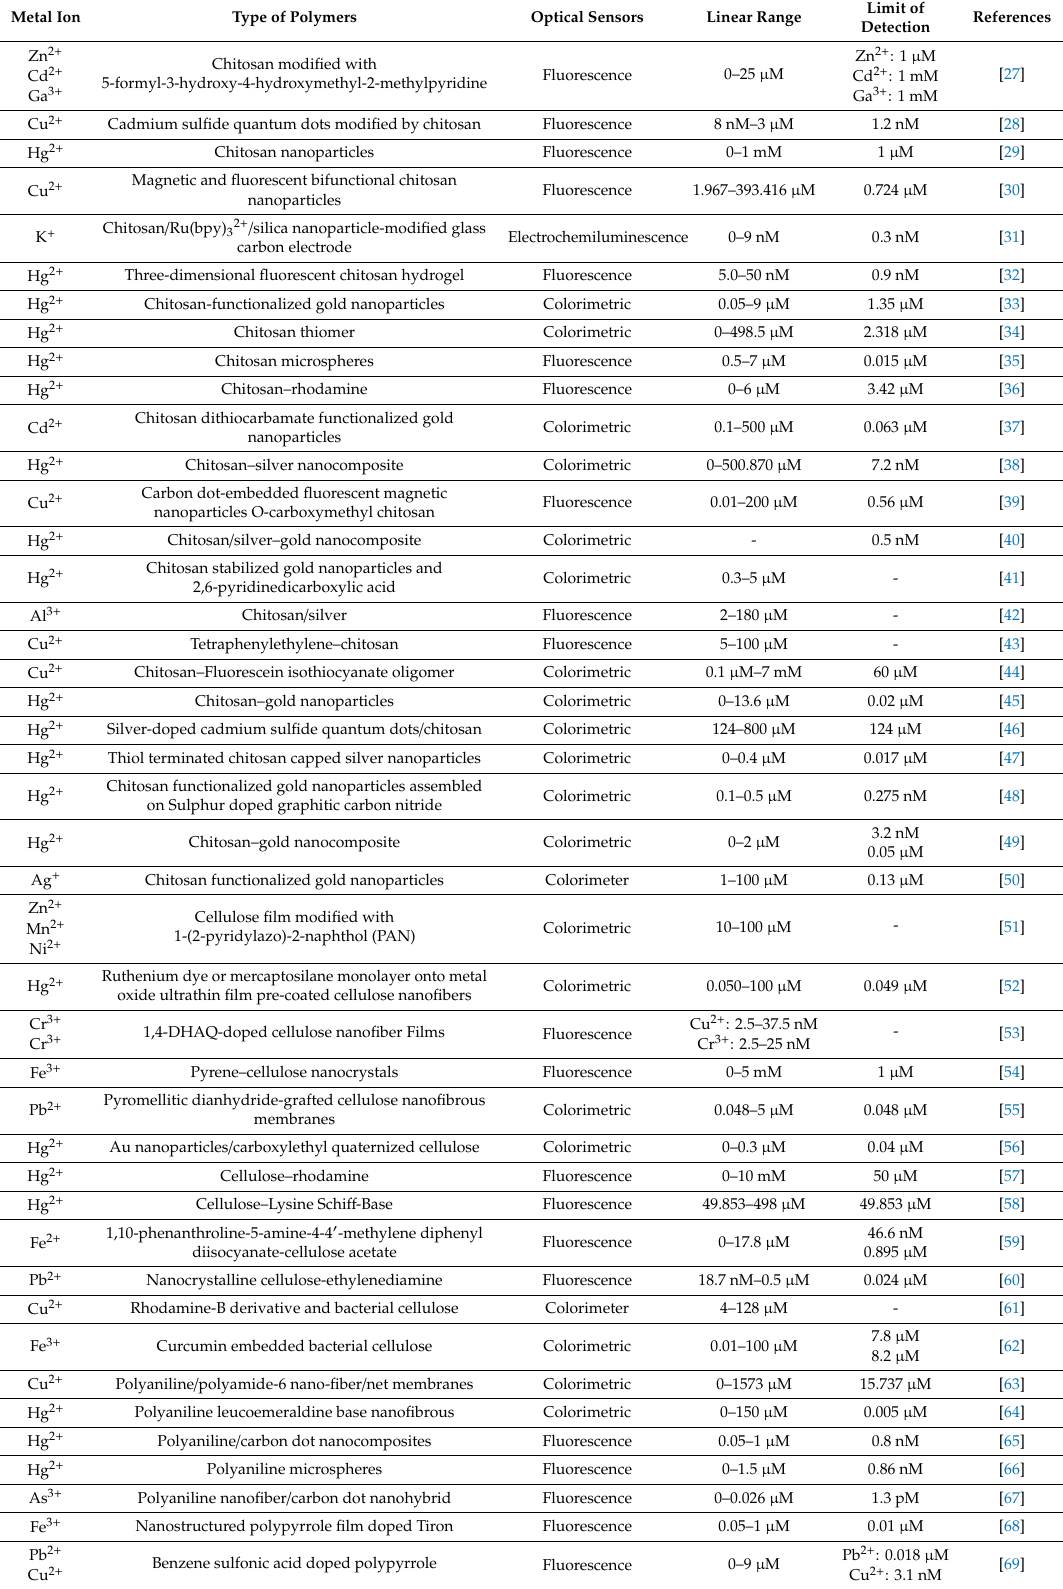
Table 1. The biopolymers and conducting polymer-based optical sensors for heavy metal ion detection. Metal